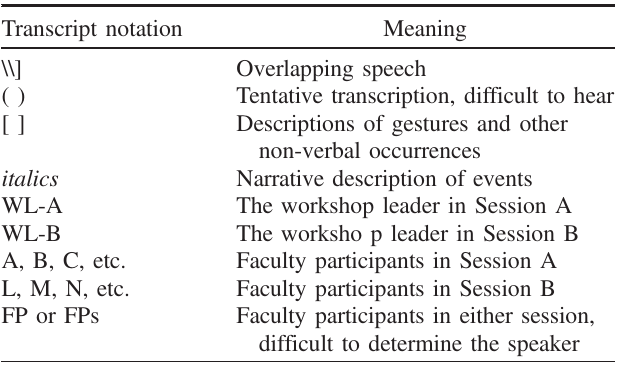
TABLE II. Conventions for transcription, largely based on Ochs [78], and speaker